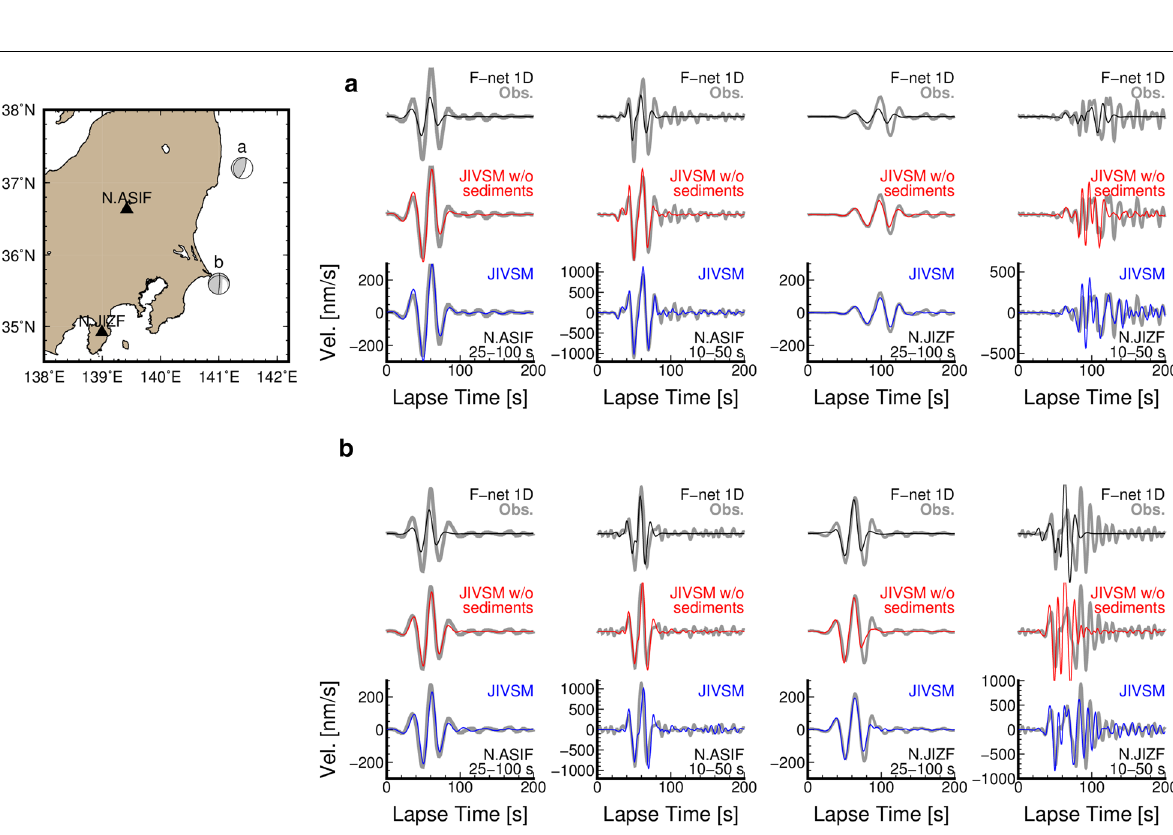
Fig. 6 Simulations of long-period ground motion in various models. Simulation results of ( a ) Event a and b Event b. Observed F-net vertical seismograms are represented by bold gray lines. The blue, red, and black lines are simulated vertical seismograms of the JIVSM, JIVSM without sediments, and F-net 1D model, respectively. The physical parameters of sedimentary layers of the JIVSM without sediments were replaced with those of the upper crust (see Table 1). Locations of seismic sources and stations are illustrated in the upper left panel. Plotted focal mechanisms are the optimal solutions of events a and